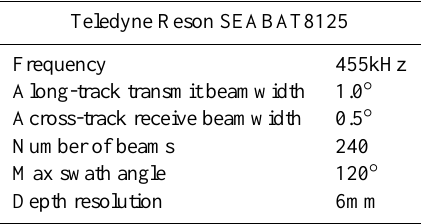
Table 1. Specification of multi-beam